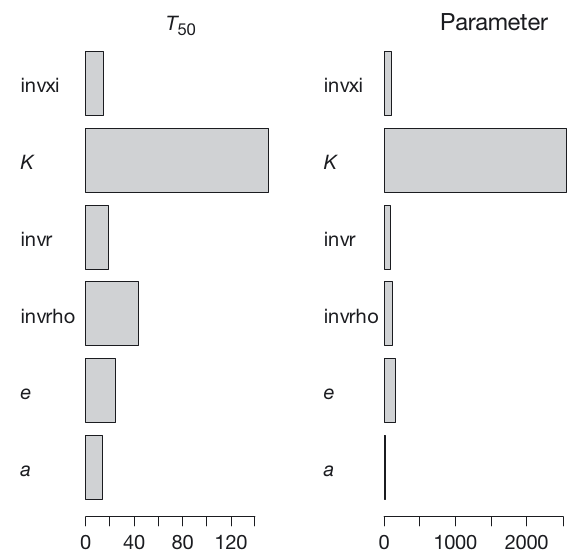
Fig. 10. Sensitivity analysis of the model output to the epi- demiological parameters. Left: relative difference (%) of the time to obtain 50% mortality ( T 50 ) when parameters at low temperature replaced the value at high temperature. Right: relative difference (%) between low and high temperature values. Parameter names: invrho = 1/ ρ ; invxi = 1/ ξ ; invr = 1/ r (see Table